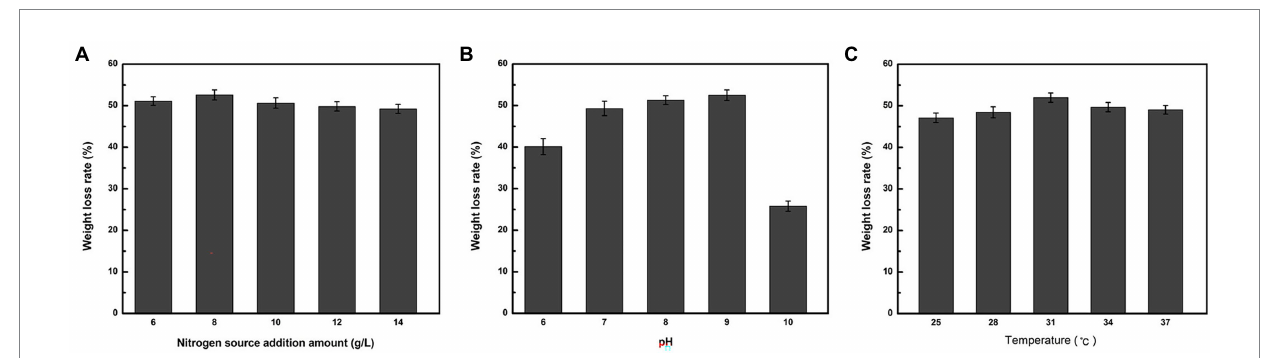
FIGURE 3 The response surface of the interaction of temperature, pH, and Nitrogen source addition amount of ZJW-6 on the degradation rate. (A) Response surface affected by Nitrogen source addition amount and pH interaction. (B) Response surface affected by Nitrogen source addition amount and temperature. (C) Response surface affected by pH and